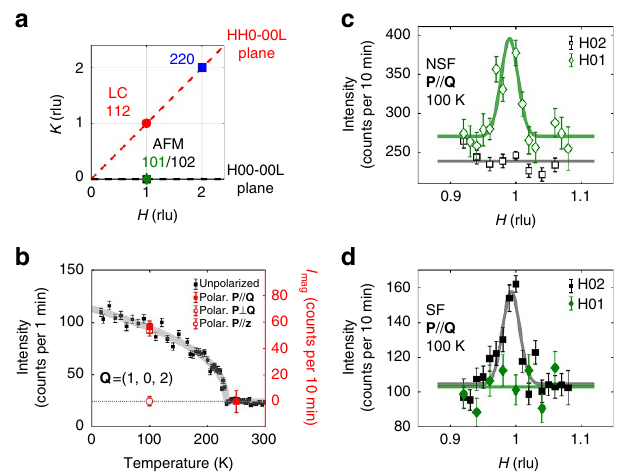
Figure 2 | AFM order in Sr 2 IrO 4 . ( a ) Momentum transfer Q positions (projected in the reciprocal HK -plane) investigated with neutron scattering: (1, 0, L ¼ 1, 2) corresponds to the AFM Bragg peaks, whereas (1, 1, 2) is where a magnetic scattering is expected for the LC phase. ( b ) Thermal evolution of the peak intensity at the AFM Bragg peak (1, 0, 2) measured by unpolarized neutron (black) and the full polarization analysis at T ¼ 100 and 250K (red) (see text). ( c , d ) The ( H , 0, L ¼ 1, 2) scans at 100K for both the non-spin-flip (NSF) (empty symbols) and spin-flip (SF) (full symbols) channels (diamond symbols for L ¼ 1 and square symbols for L ¼ 2). While the (1, 0, 2) peak (black squares) shows purely magnetic behaviour, the (1, 0, 1) (green diamonds) shows a purely nuclear